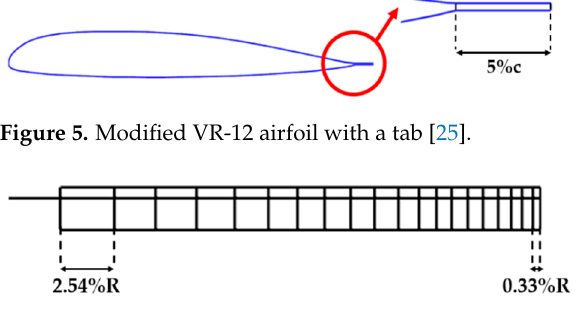
Figure 6. Aerodynamic panels in CAMRAD II model.